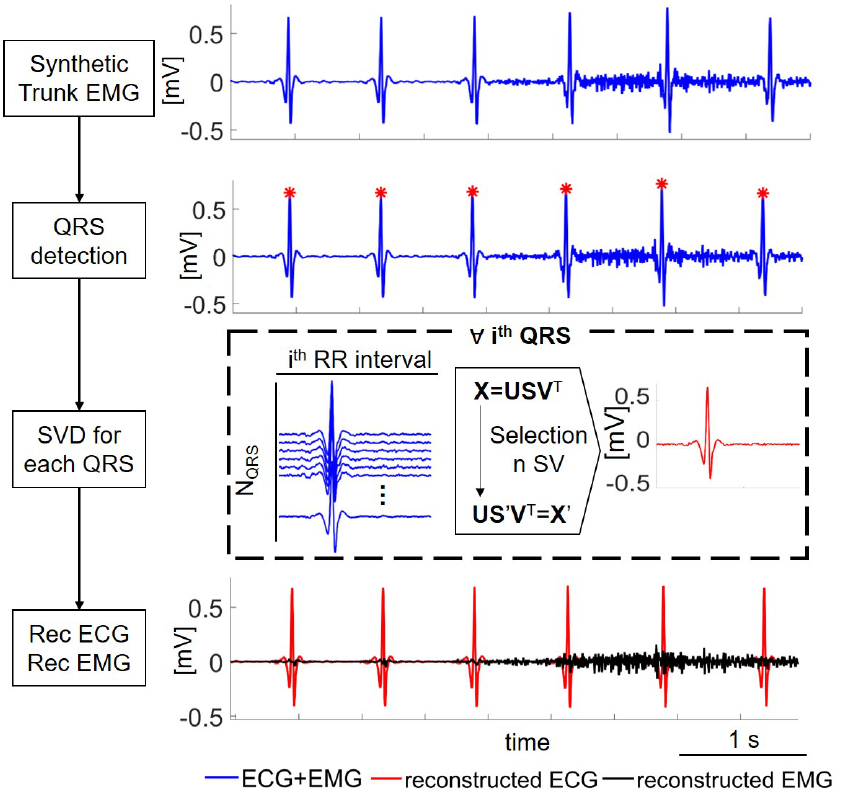
Figure 2. Schematic of the algorithm proposed with an illustrative synthetic trunk EMG (SNR = 10 dB). The EMG signal during the first three QRScomplexes was the minimum (rest phase), while the last three QRS were overlapped with the EMG at 50% maximal voluntary contraction (MVC). Firstly, the synthetic trunk EMG signal was processed to find the QRS complexes. For each i th QRS, a matrix X was built. Each row of X was composed by a single QRS centered 0.3 s before the R peak, with the length equal to the current RRinterval. Finally, the ECG component was extracted through inverse SVD considering n singular values, and it was subtracted from the mixed